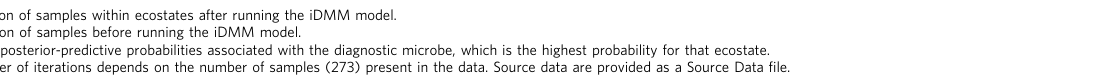
a Distribution of samples within ecostates after running the iDMM model. b Distribution of samples before running the iDMM model. c Bayesian posterior-predictive probabilities associated with the diagnostic microbe, which is the highest probability for that ecostate. The number of iterations depends on the number of samples (273) present in the data. Source data are provided as a Source Data fi